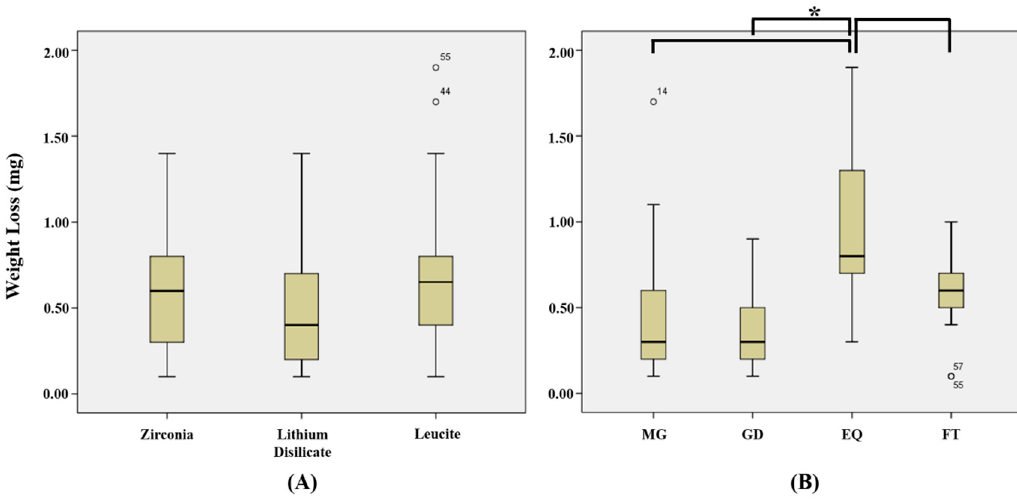
Figure 6. Weight losses of composite resin specimens (mg): ( A ) Mean weight loss of composite resin according to ceramic type. ( B ) Mean weight loss of composite resin regardless of ceramic type. MG, MI Gracefil; GD, Gradia Direct P; EQ, Estelite Σ Quick; FT, Filtek Supreme Ultra. * Statistical significance.